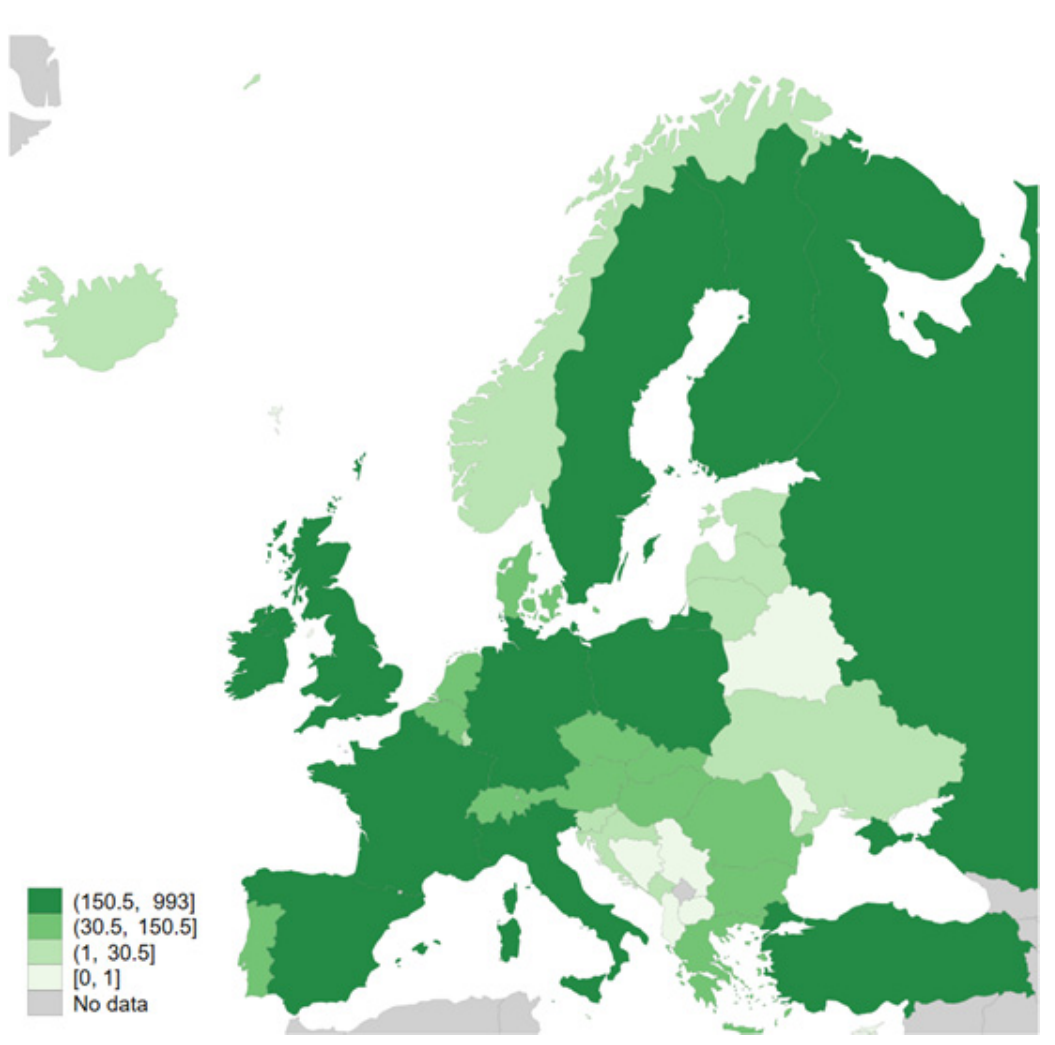
Figure 3. Spatial distribution of LEED-registered projects in Europe in